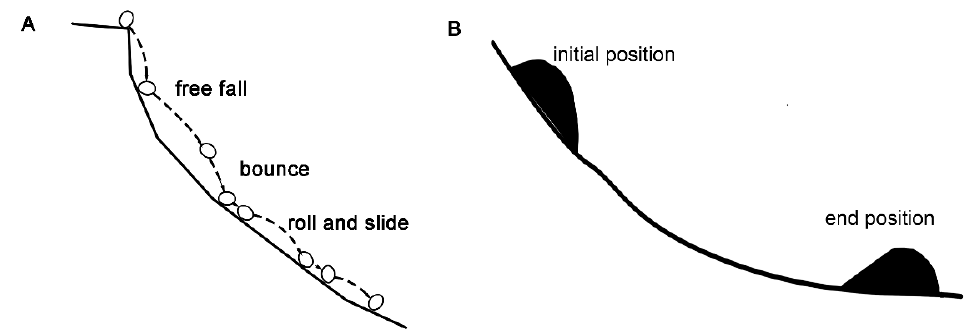
Figure 1. Two main motion processes: ( A ) the rigid body motion, and ( B ) the flow-like motion.